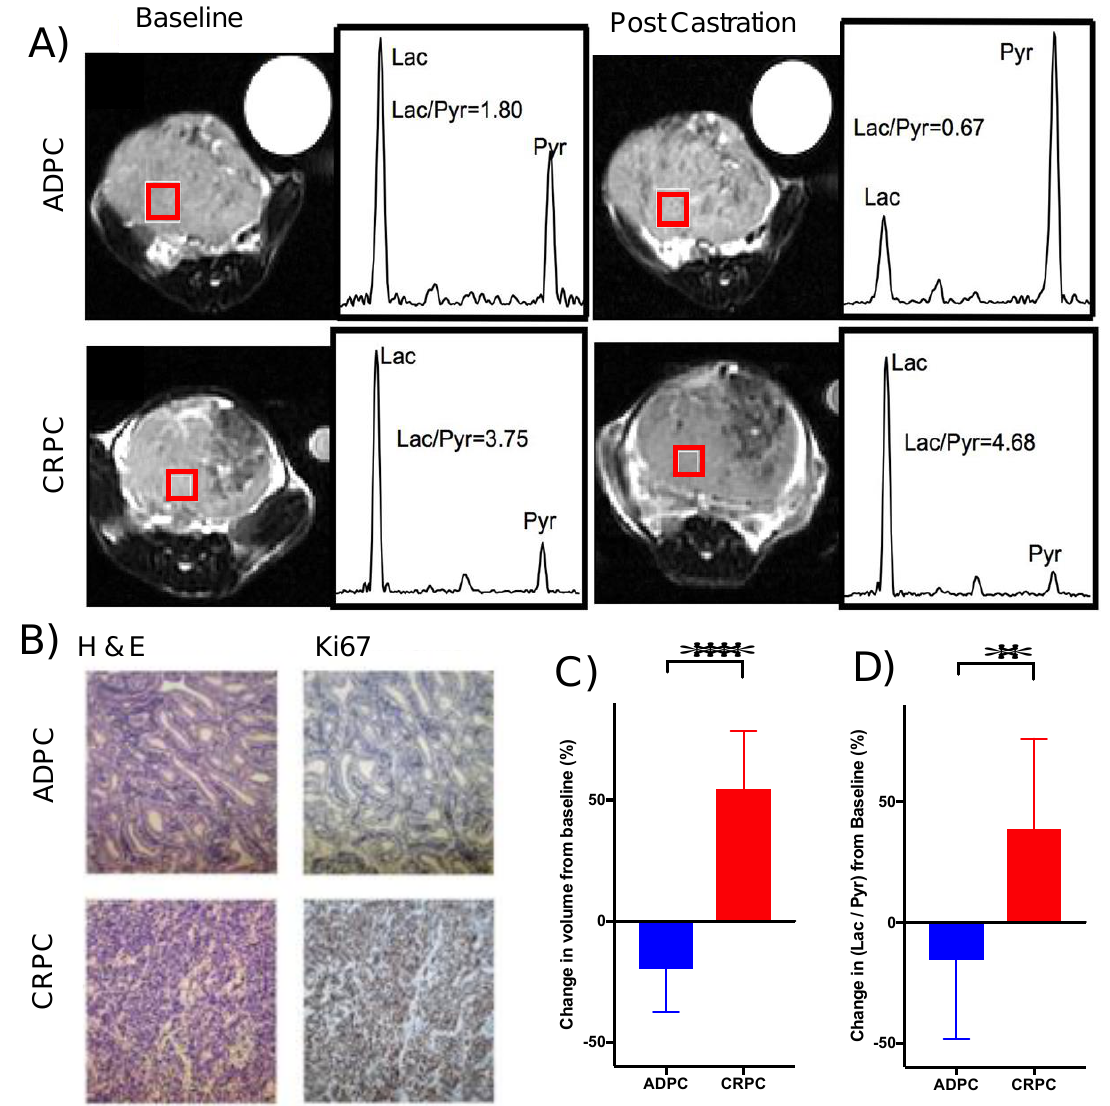
Figure 9. In vivo metabolism of HP [1- 13 C]pyruvate in a treatment-driven TRAMP model. ( A ) Representative T2-weighted proton images of ADPC (top row) and CRPC (bottom row) TRAMP tumors at baseline (left column) and 5 days post- castration (right column). The spectrum from a voxel (red square) is shown on the right of each image of the HP lactate (Lac) and pyruvate (Pyr) and the calculated ratio (Lac/Pyr). ( B ) Representative images of immunohistochemical staining of ADPC (top row) and CRPC (bottom row) of hematoxylin and eosin (H&E) and Ki67 (indicator of proliferation). ( C ) Change in volume and ( D ) HP Lac/Pyr of TRAMP tumors from baseline to post-orchiectomy in ADPC ( n = 11) and CRPC ( n = 7) mice. ( ** p < 0.01, **** p < 0.0001)